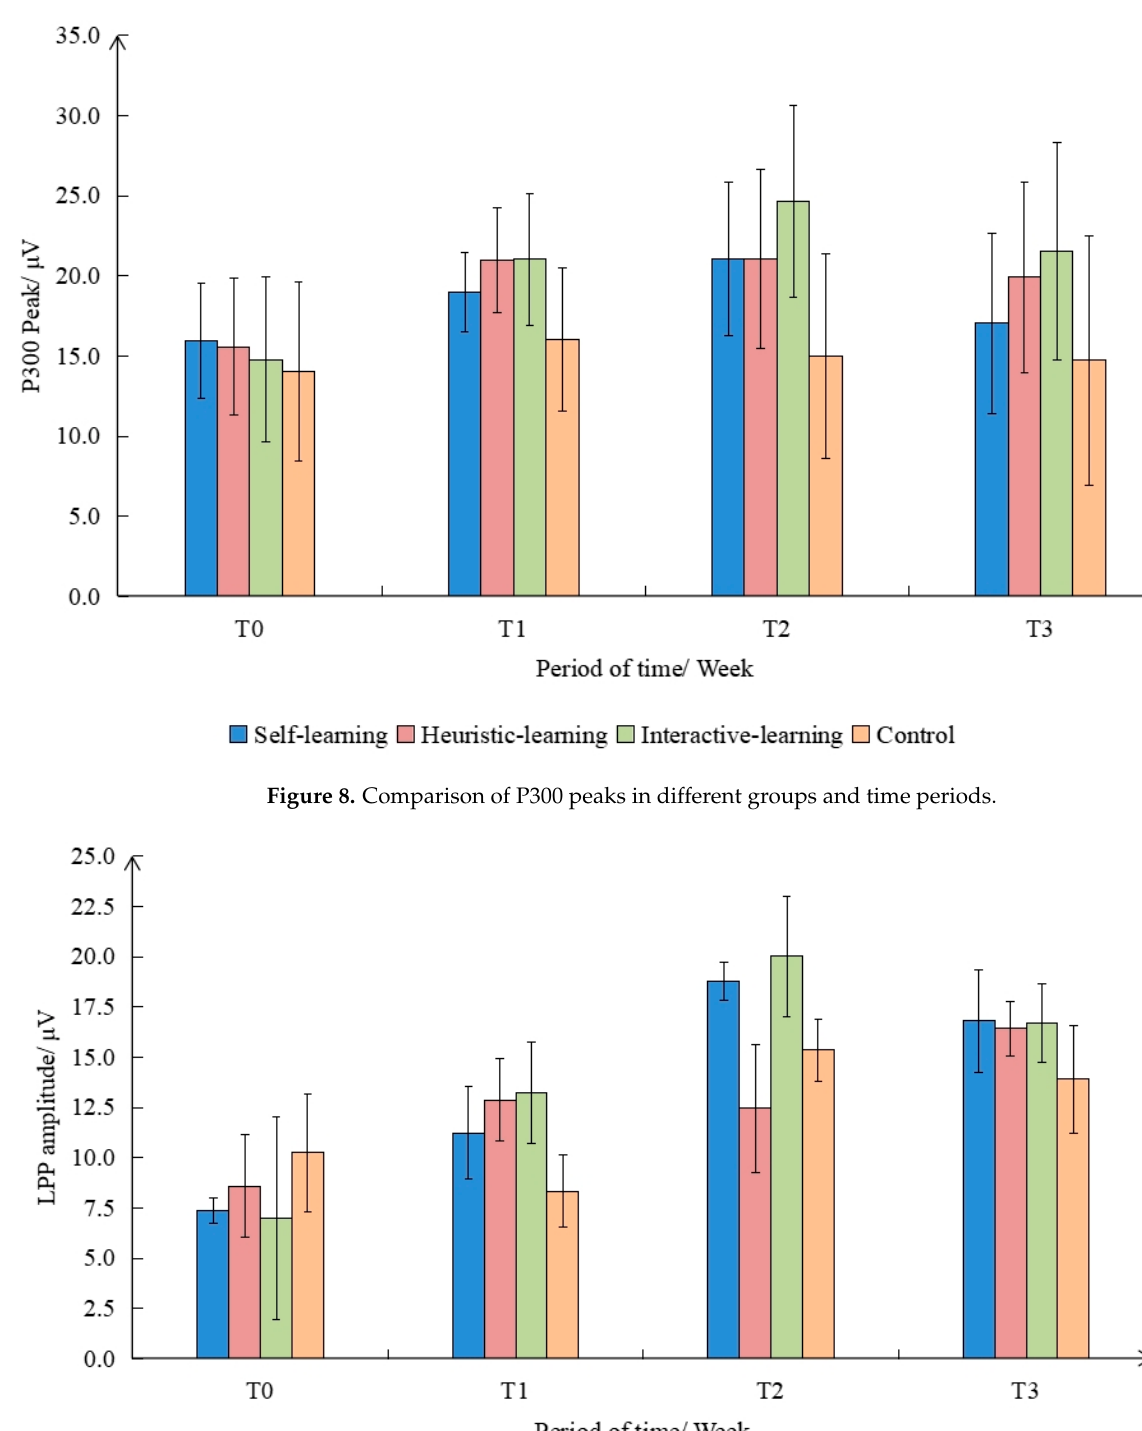
Figure 9. Mean and standard deviation of LPP amplitude under different interventions. The repeated measures of variance test for LPP amplitudes within the time window revealed a significant main effect between groups (F(3,9) = 3.419, p < 0.050). There was a significant difference in LPP amplitude between the interactive-learning group and the control group ( p < 0.050), but the difference in the other groups was not significant.